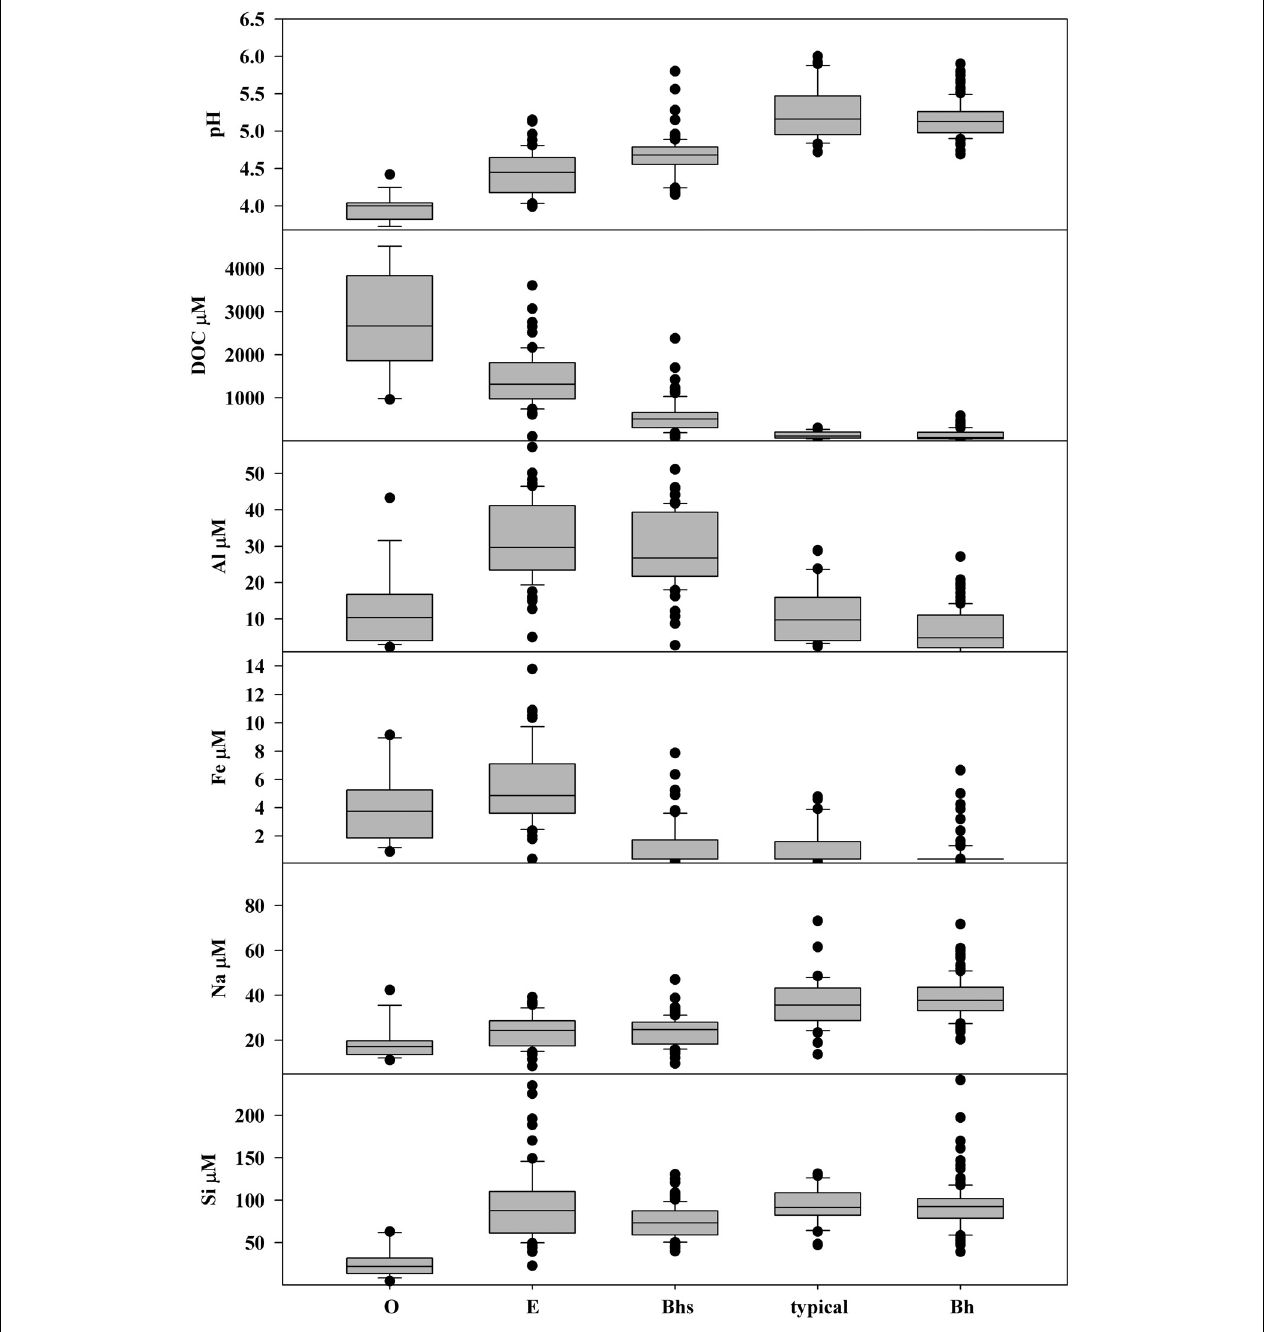
FIGURE 8 | Box plots showing the distribution of pH and concentrations of dissolved organic carbon (DOC), total dissolved aluminum Al, iron (Fe), sodium (Na), and silicon (Si) in groundwater samples from shallow wells stratified by soil type. The number of groundwater samples included was O = 16, E = 67, Bhs = 89, typical = 35, Bh =